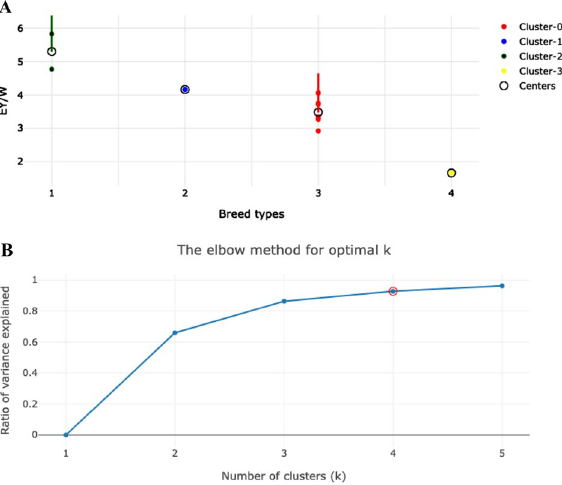
Figure 2. Cluster analysis for distribution of the 11 core breeds using the k -means ( A ) and elbow ( B ) methods. Breed (sub)types ( A ): 1, egg type (cluster-2); 2, egg-meat subtype (cluster-1); 3, meat-egg subtype (cluster-0); and 4, meat type (cluster-3). Optimal number of clusters ( k ) was 4 ( B ). EY / W , integral performance index as a ratio of egg mass yield ( EY ) and female body weight ( W